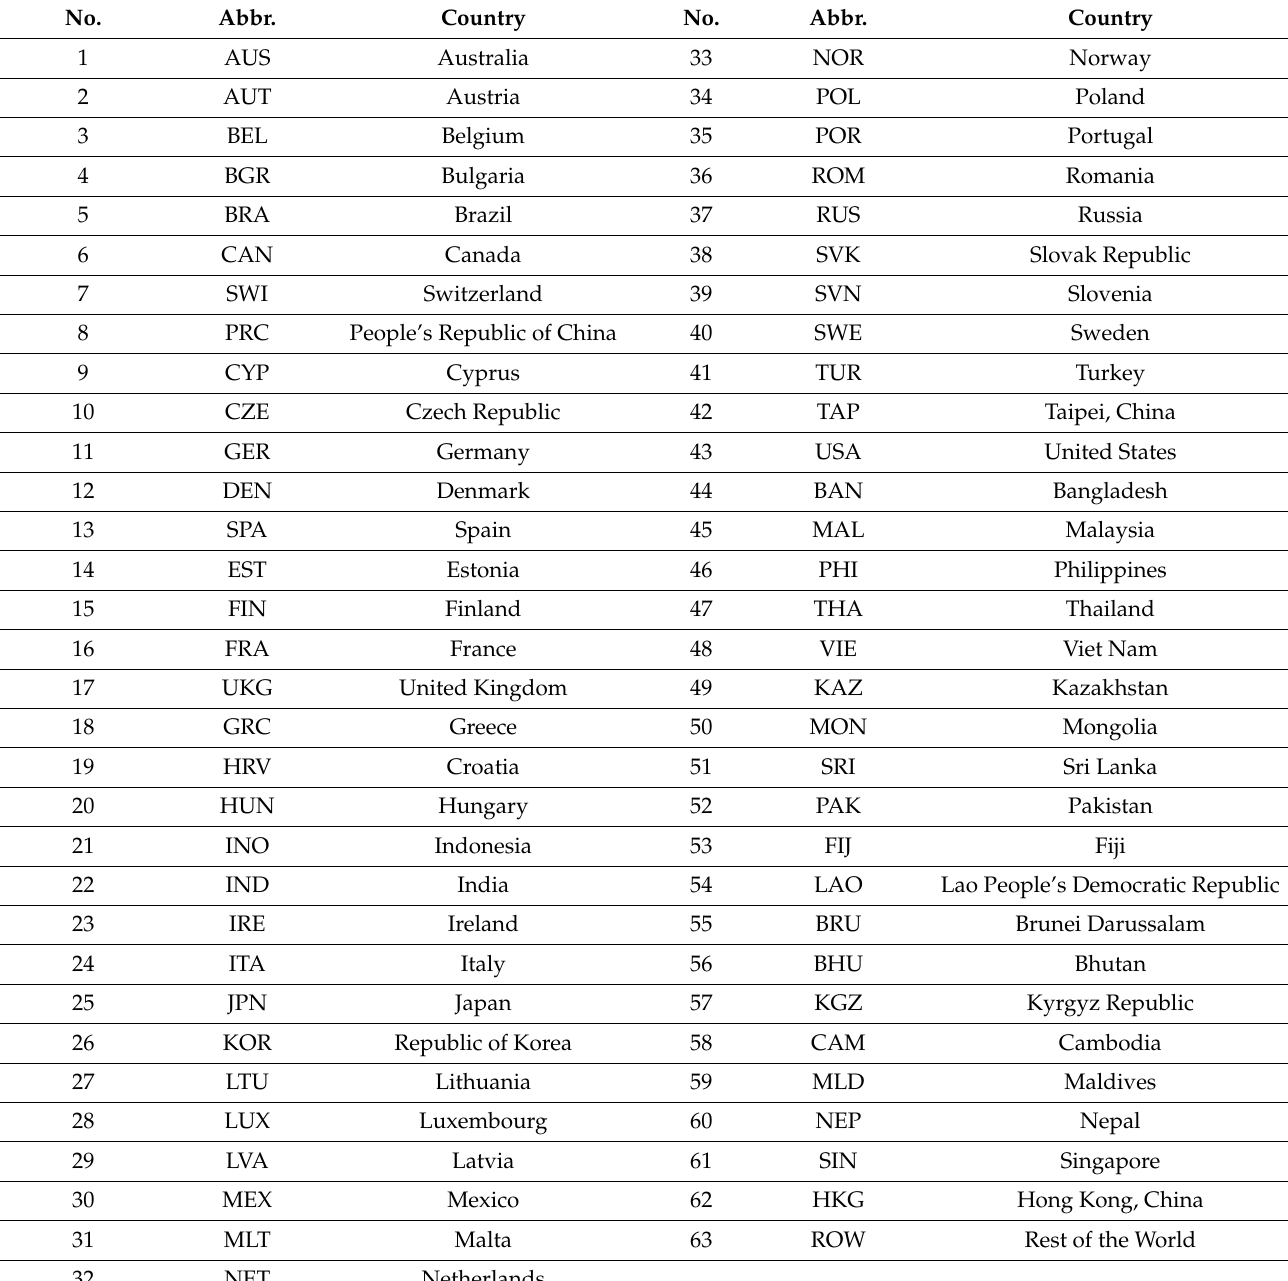
Table A1. Countries/Regions’ Names and Their Abbreviations in